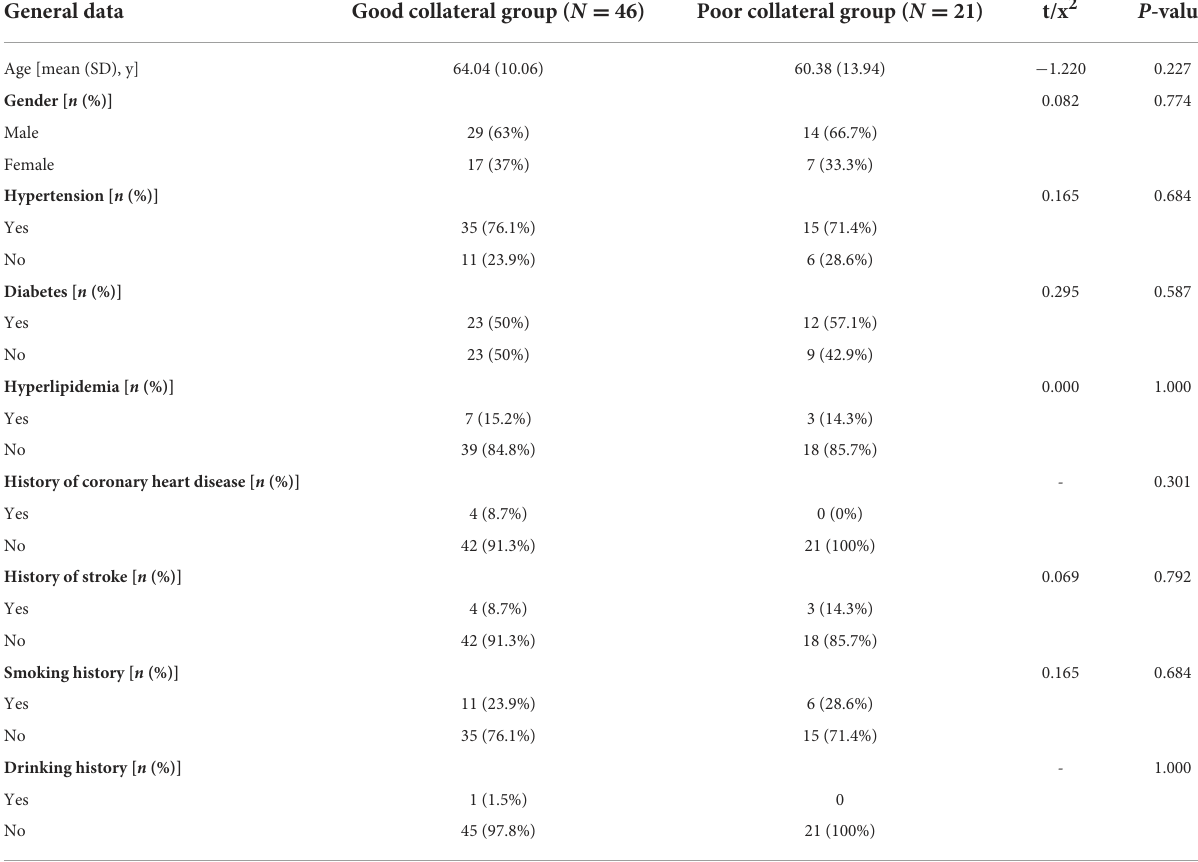
TABLE 1 General data of the included patients. General